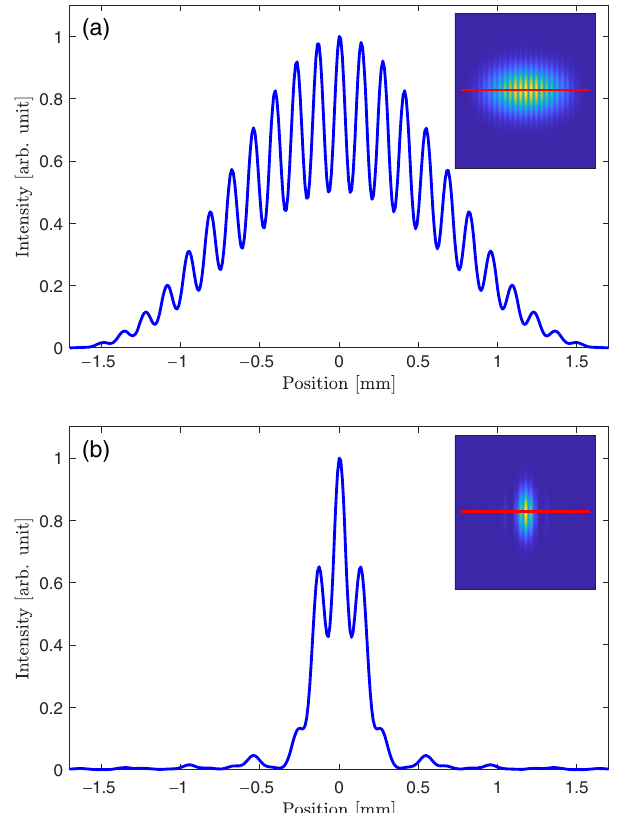
FIG. 1. Illustration of interference patterns simulated using the Synchrotron Radiation Workshop ( SRW ) with two different double slits. (a) Simulated for a conventional SRI measurement system with a large number of interference fringes inside the main diffraction envelope. The slit separation is 5 mm and the slit opening is 0.4 mm. (b) Simulated for an SRI system with a large slit opening and a relatively small slit separation: only a few interference fringes are present inside the main diffraction envelope. The slit separation is 5 mm and the slit opening is 1.8 mm. For each subplot, the inset shows the image of the interference fringes. In each subplot, the projection of the simulated intensity distribution is shown with the data from a red rectangle in the inserted image. The x axis is scaled to be equal in both